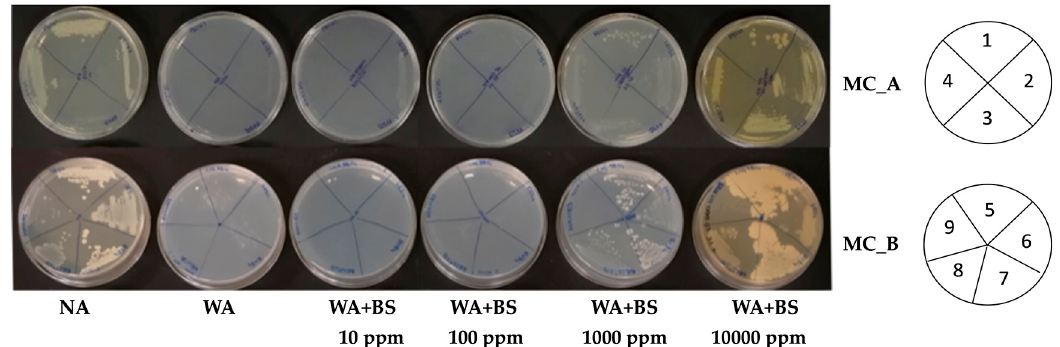
Figure 3. Bacterial strains belonging to microbial consortia (MC)_A (on the top) and MC_B (on the bottom) growing in starvation conditions in the presence or absence of BS2 ranging from 10 ppm to 10,000 ppm. Tested strains for MC_A: B. licheniformis PS141 ( 1 ), A. chroococcum LS132 ( 2 ), K. pastoris PP59 ( 3 ), P. granadensis A23/T3c ( 4 ), MC_B: B. amyloliquefaciens LMG 9814 ( 5 ), P. fluorescens DR54 ( 6 ), Bacillus sp. BV84 ( 7 ), R. aquatilis BB23/T4d ( 8 ), and A. vinelandii DSM 2289 ( 9 ). For a better view of the position of each strain, a plating scheme was added to the right. The plates on the right report the numbers corresponding to each of the tested strains in MC_A ( 1 – 4 ) and MC_B ( 5 – 9 ). The bio-assay was performed in triplicate. NA = Nutrient agar; WA = water agar; BS =